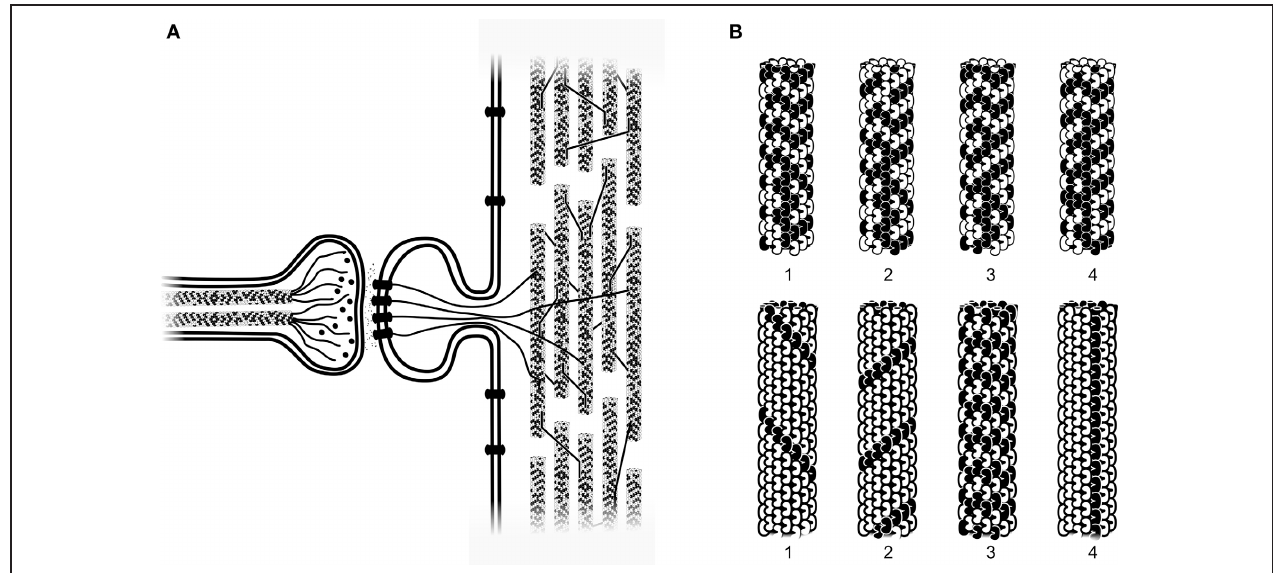
FIGURE 5 | (A) Axon terminal (left) with two internal microtubules releasing neurotransmitters into synapse and onto receptors in membrane of dendritic spine. Actin filaments (as well as soluble second messengers, not shown) connect to cytoskeletal microtubules in main dendrite. Dendritic microtubules (right) are arranged in local networks, interconnected by microtubule-associated proteins (MAPs). (B) Largerscaleshowingtwotypesof